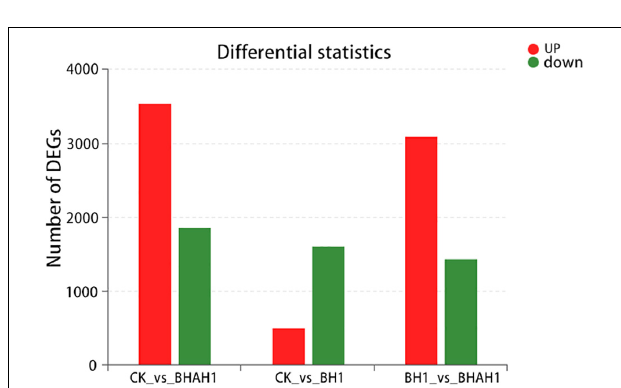
FIGURE 3 | KEGG metabolic pathways. The X -axis indicates the number of genes/transcripts annotated to the respective pathways. KEGG metabolic pathways can be divided into seven categories: metabolism, genetic information processing, environmental information processing, cellular processes, organizational systems, human diseases, and drug development.